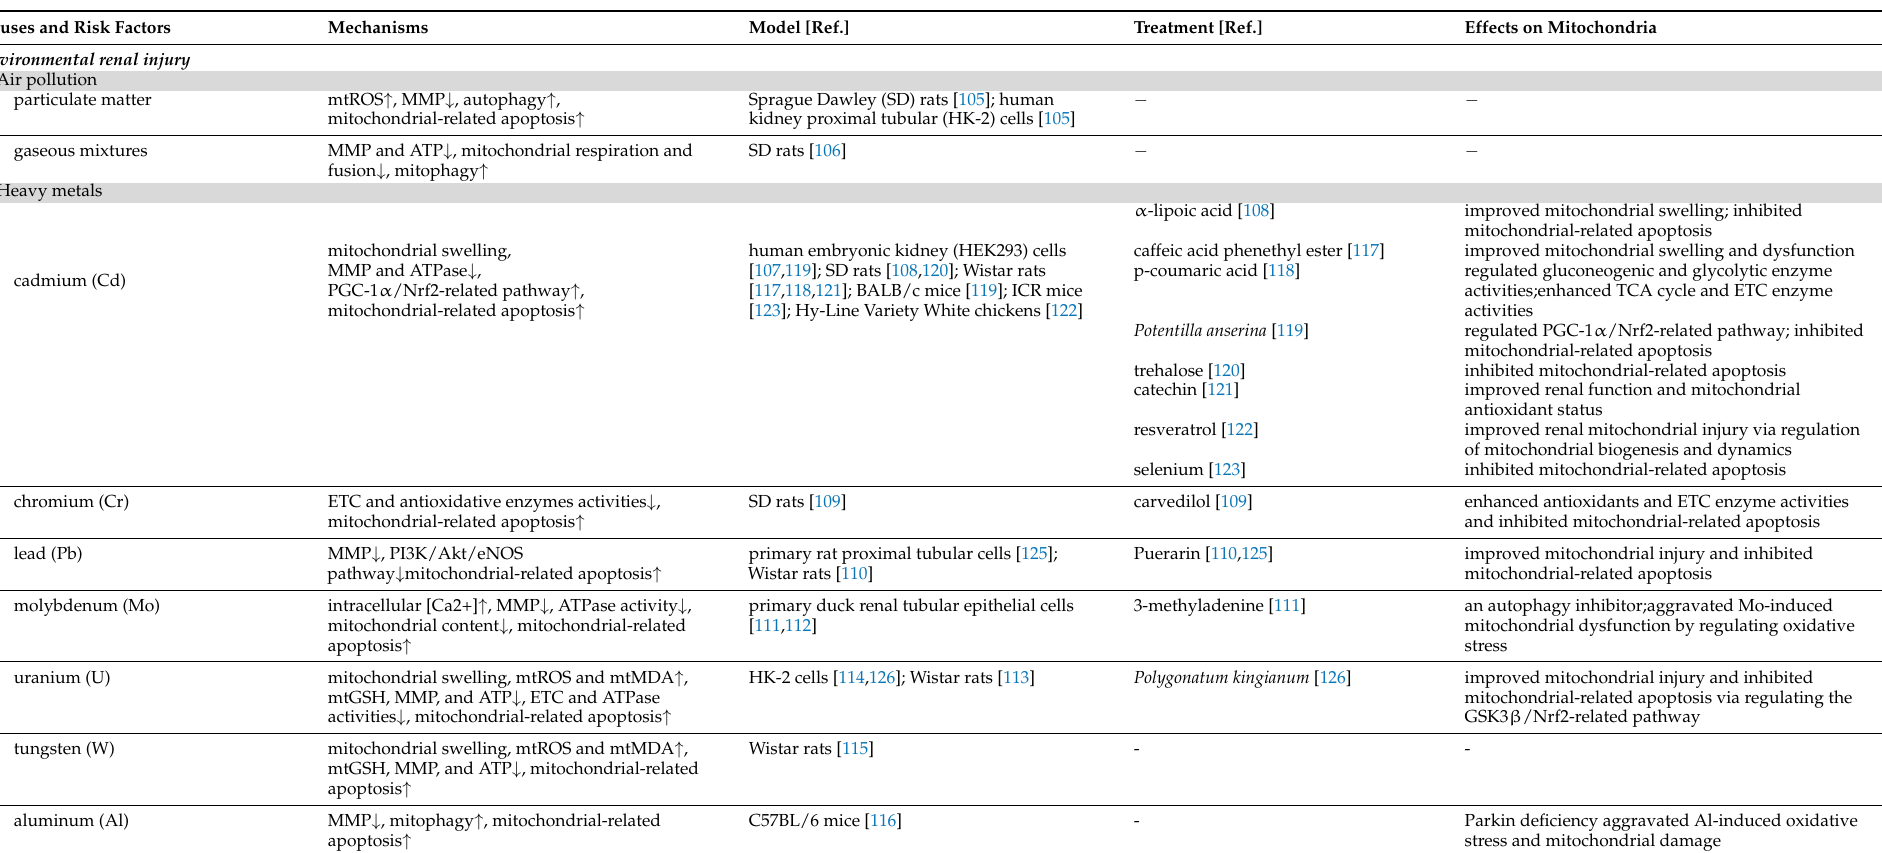
Table 1. The causes and risk factors of mitochondrial-related oxidative injury in the kidneys or renal cells. The treatments which can improve renal injury and antioxidant status and their protective effects on mitochondrial function were listed. ↑ indicates an increase or an up-regulation, ↓ indicates a decrease or a down-regulation in the